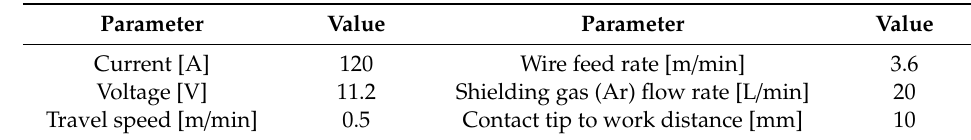
Table 2. Process parameters for STS 316L